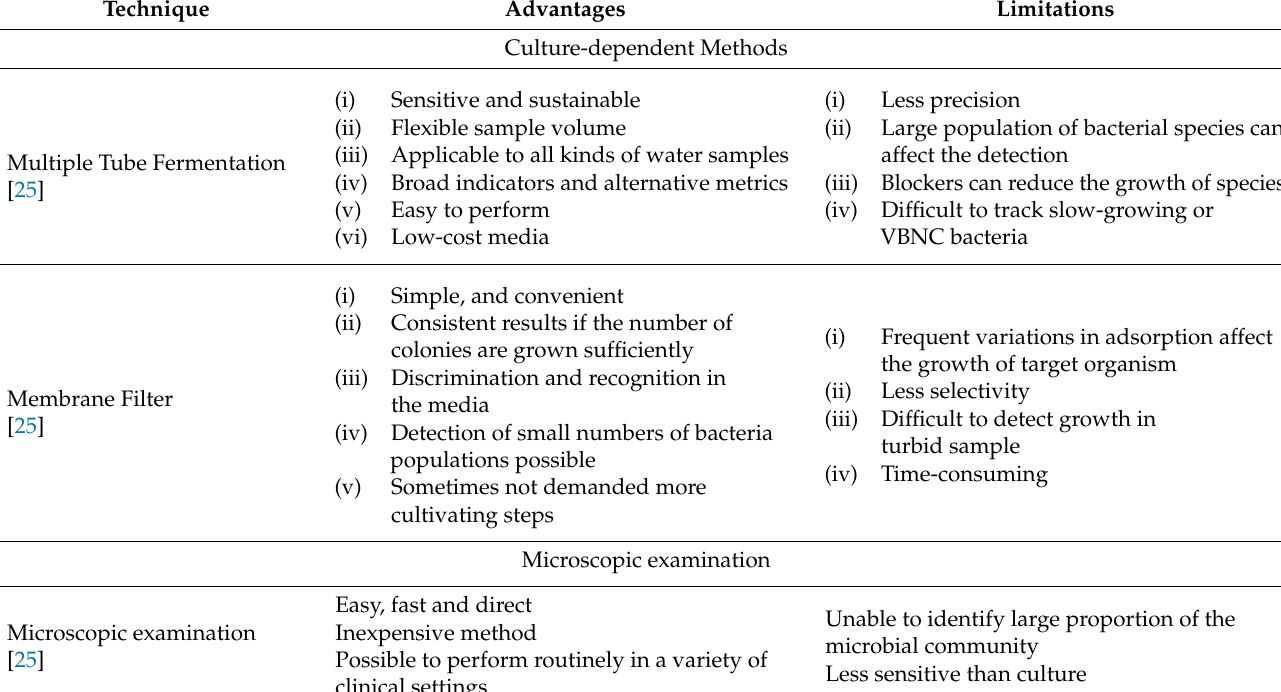
Table 1. Advantages and limitations of conventional techniques used to detect microbial pathogens in environmental